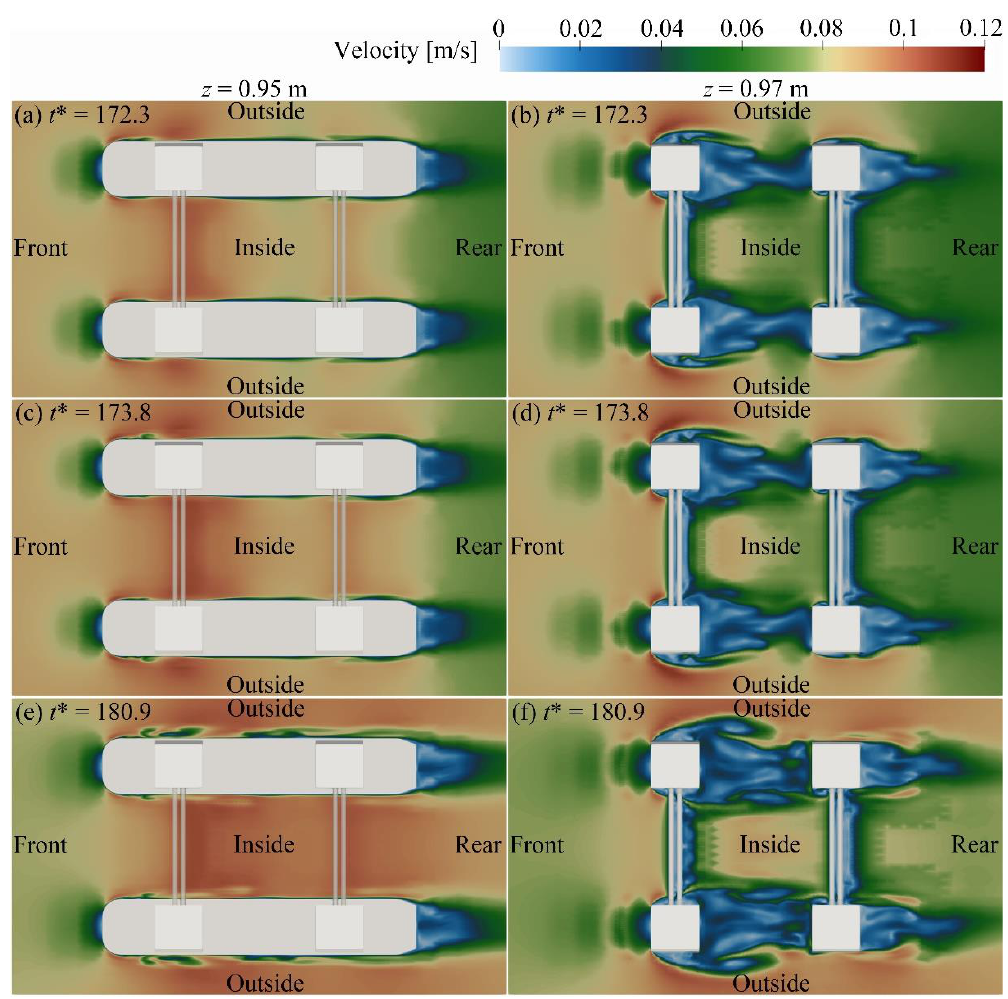
Figure A1. Velocity around the platform at z = 0.97 m and z = 0.95 m for Case A2. Water 2020 , 12 , x FOR PEER REVIEW